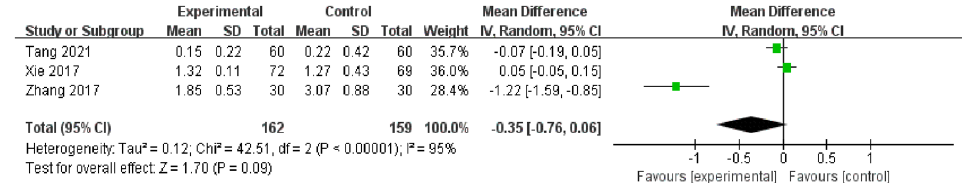
Figure 9. Artificial tears vs. Artificial tears plus Auricular acupressure on CFS [50–52]. Response Rate